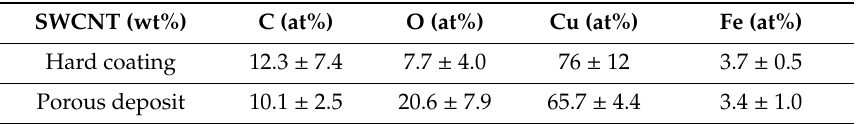
Figure 8. SEM images of hard adherent coatings ( a , b ) and related porous deposit ( c ) as obtained through the modified electrochemical plating process on copper wire cathodes. Table 6. EDX analysis of electroplated Cu–SWCNT composites electrodeposited at a bath temperature of 60 °C in the presence of micropowder copper.